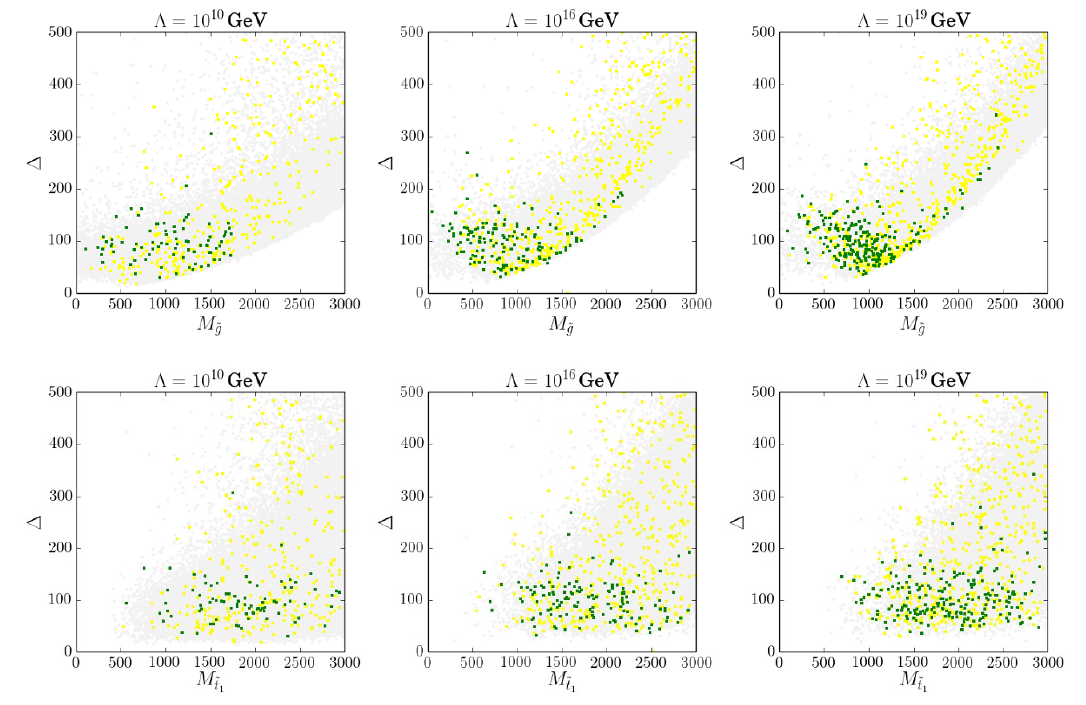
Figure 4 . Same as in (cid:12)gure 1 with higher NP scales and in a narrower scan range supporting the infrared (cid:12)xed-point behavior for (cid:6). Note the reduced range of (cid:1) values on the y-axis and higher (cid:3) values compared to (cid:12)gure 1. Small (cid:12)ne tuning of (cid:1) < O (100) can be achieved even for heavier sparticle masses > 1